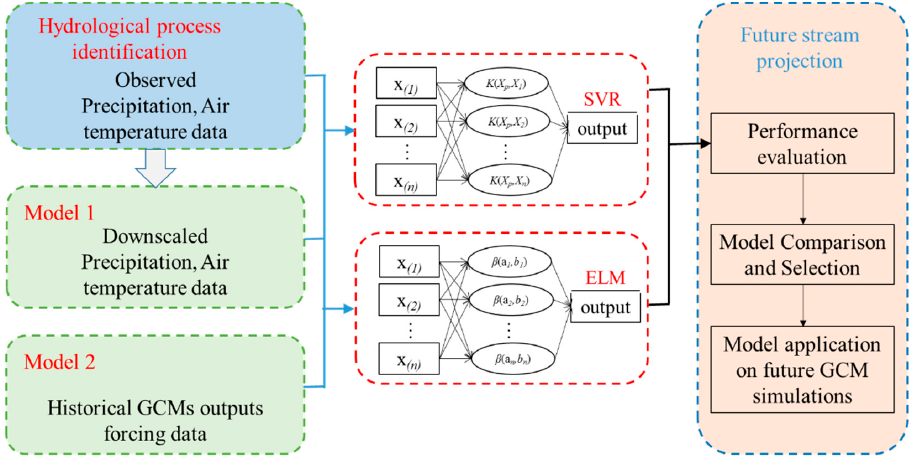
Figure 2. Schematic diagrams for future hydrological response projection.